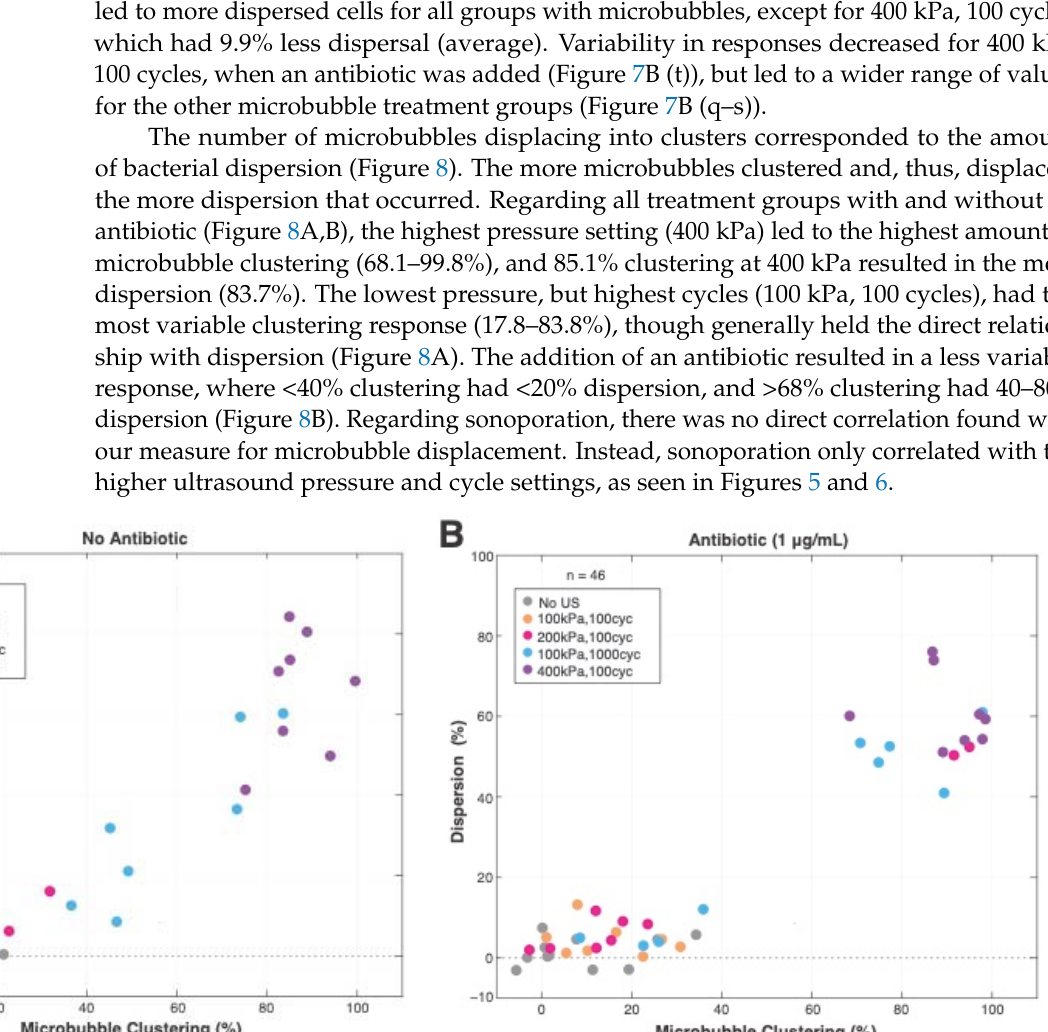
Figure 7. Dispersion of bacteria within biofilms (Equation (3); dispersion (%)). Key statistically sig- nificant differences are indicated with * p < 0.05. or ** p < 0.01. Black circles denote outliers. Statistical significance from all other groups within the same graph are marked by a (#). If adding an antibiotic, ( B ) was different from the same treatment without ( A ), which is denoted with (&) for p < 0.05. cyc = cycles; US = ultrasound. See Supplementary Table S4 for all statistical comparisons.